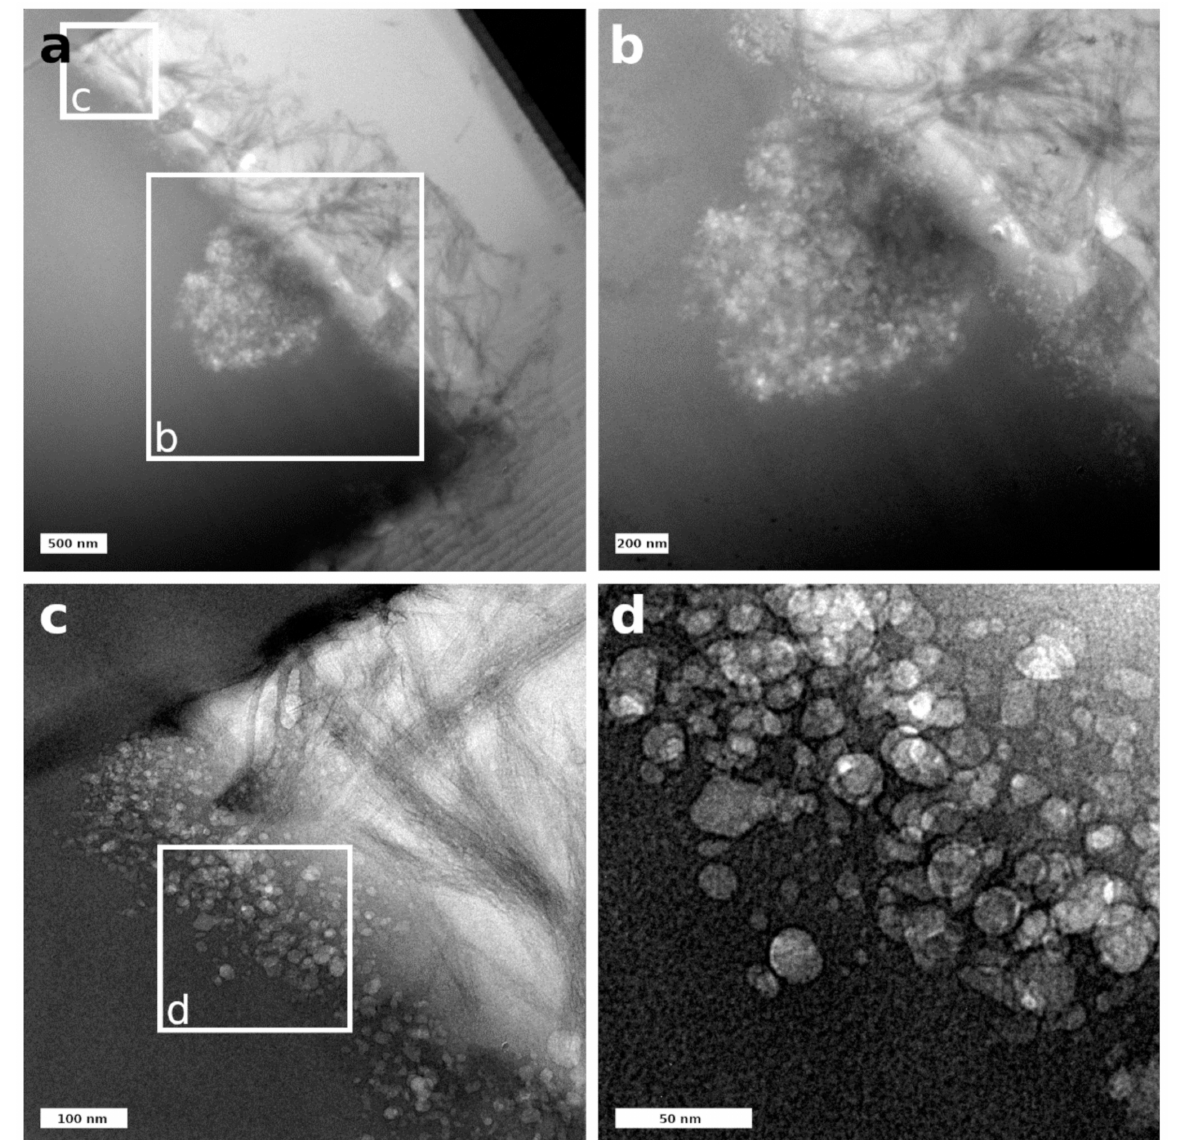
Figure 9. ( a ) Overview of the pristine glass–porous altered layer interface, ( b ) close-up of the large pore (image a), ( c ) close-up of the pristine glass–porous altered layer interface (image a), ( d ) close-up of pores in the altered layer (image c). STEM-HAADF investigations allowed for a more detailed structural and chemical view at the very delicate zone of porous altered layer and secondary phases (Figure 10). In